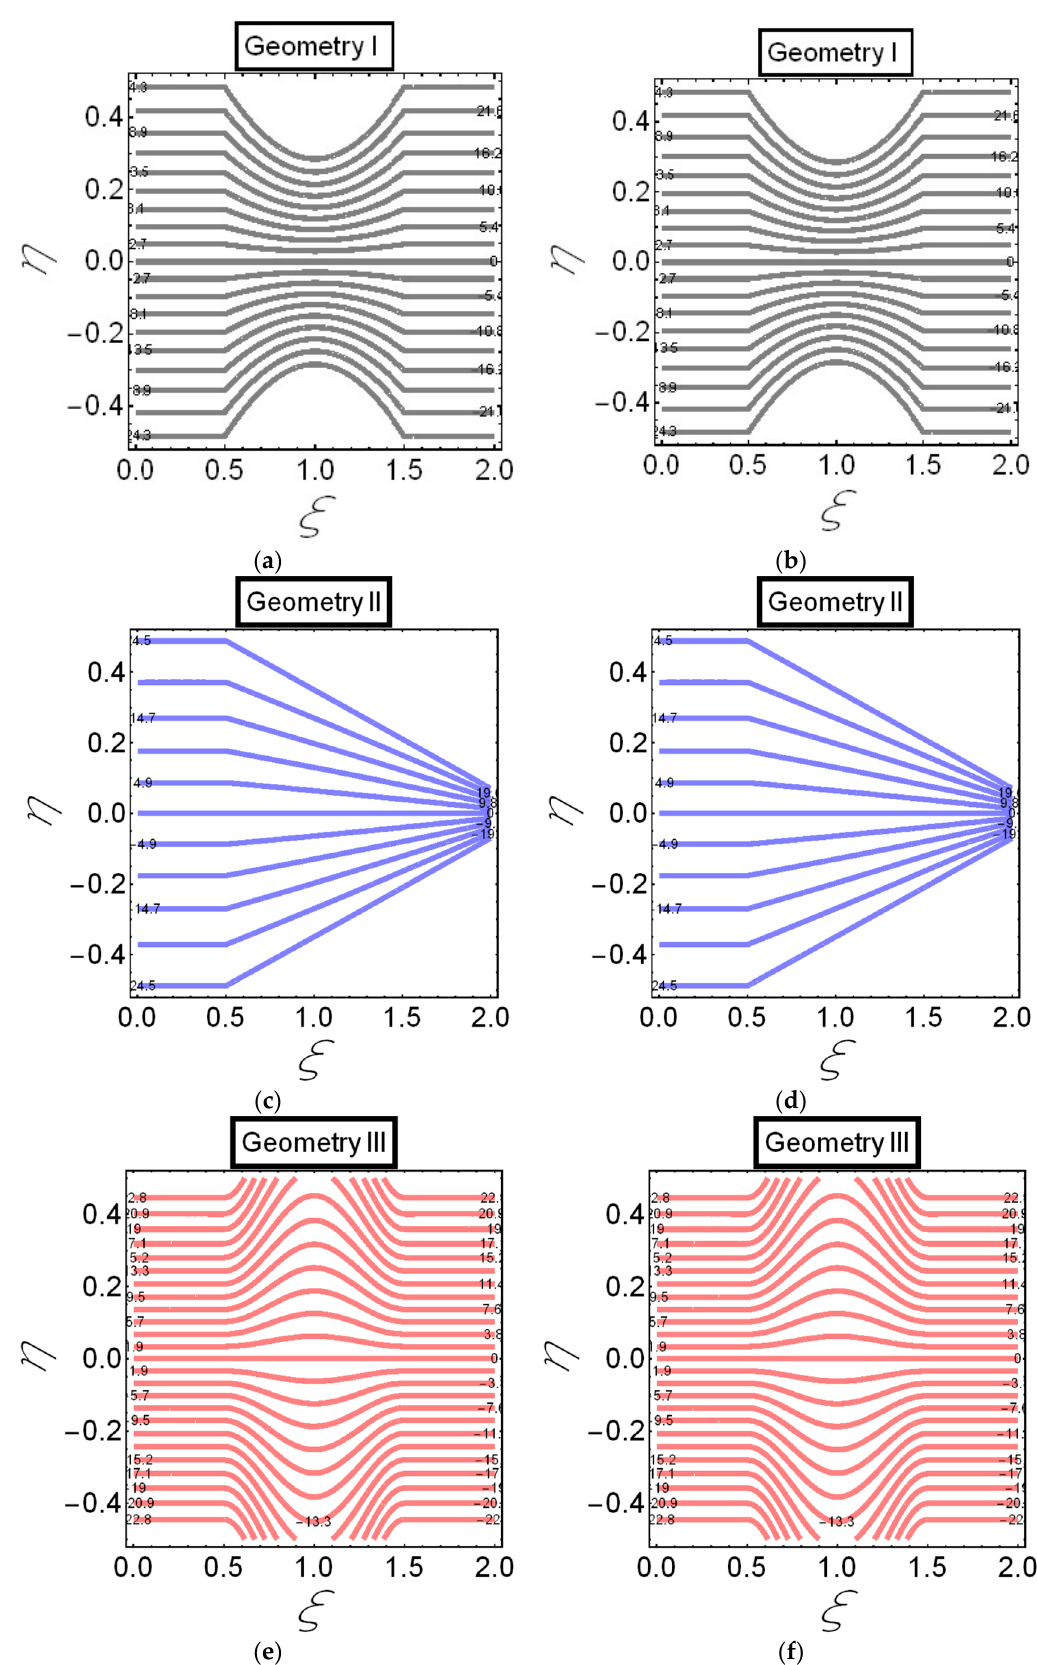
Figure 12. Streamlines for M = 2 ( a , c , e ) and M = 5 ( b , d , f ).